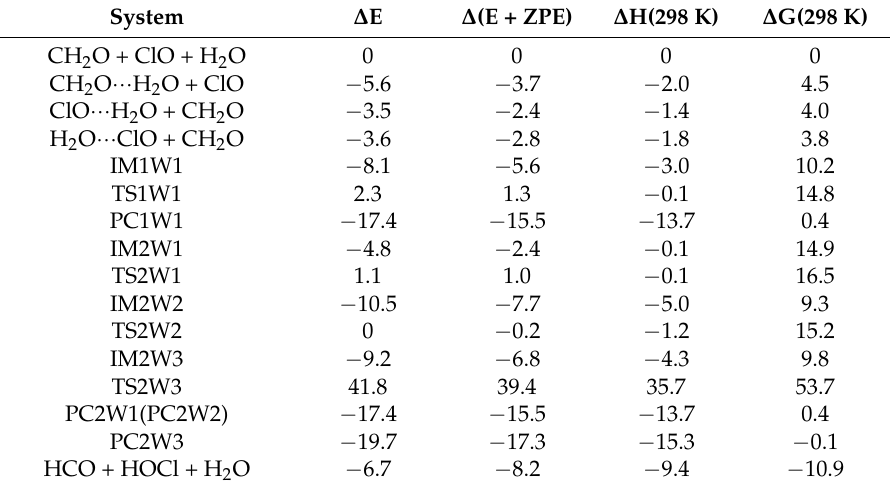
Table 3. Electronic energies ( ∆ E and ∆ (E + ZPE)), enthalpies [ ∆ H(298 K)], and Gibbs free energies [ ∆ G(298 K)] for the reaction with a single water molecule occurring through CH 2 O ··· H 2 O + ClO and ClO ··· H 2 O + CH 2 O. The units of the energies are kcal mol − 1 .